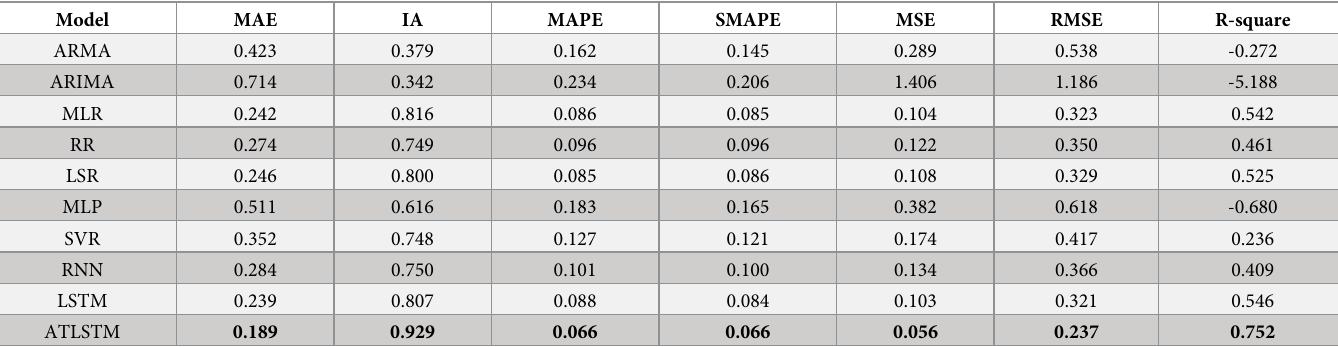
Table 3. Test results of the training